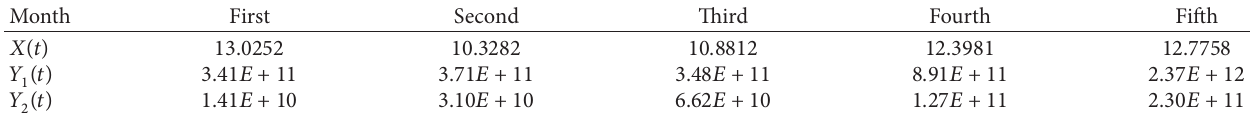
Table 3: The input and outputs center of gravity for DMU 2